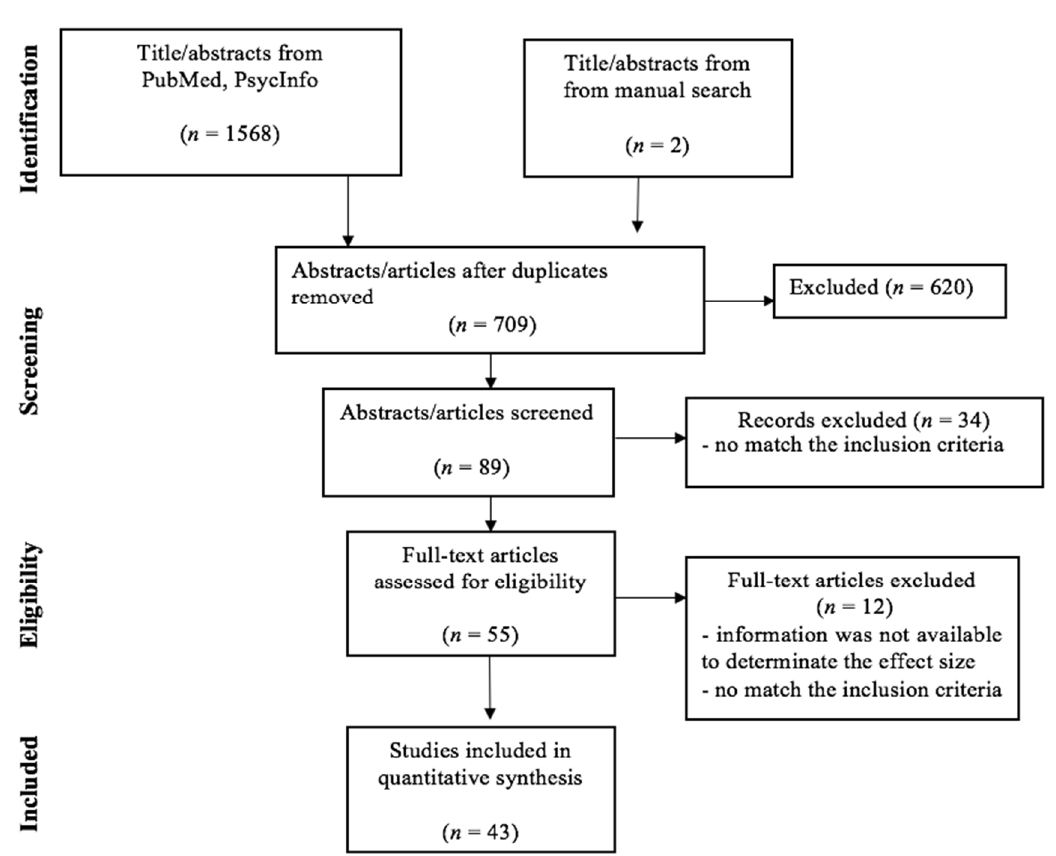
Figure 1. Identification of independent studies for inclusion in the meta-analysis (flow chart). Forty-three studies of 57 cohorts, because some studies were considered more than once. Search Strategy: Limits: English; Search terms included: worry/rumination/brooding/repetitive thinking combined using Boolean “AND” operator with eating disorder/anorexia/bulimia/binge eating disorder.